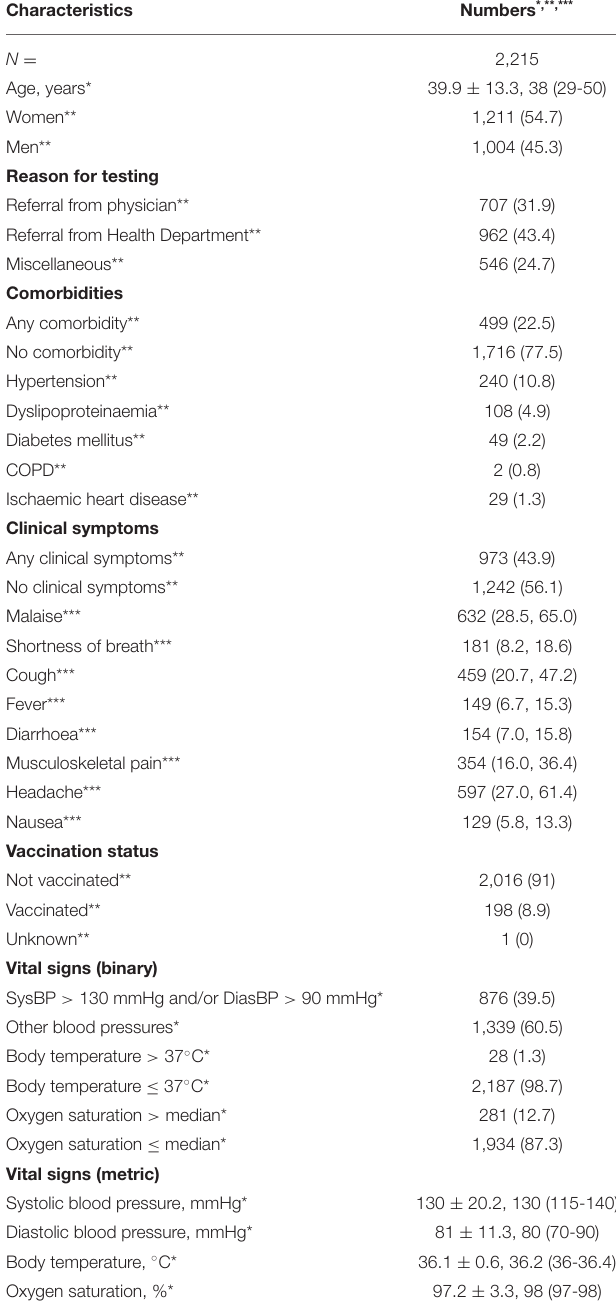
TABLE 1 | Clinical characteristics of the 2215 participants in the COVAG study.